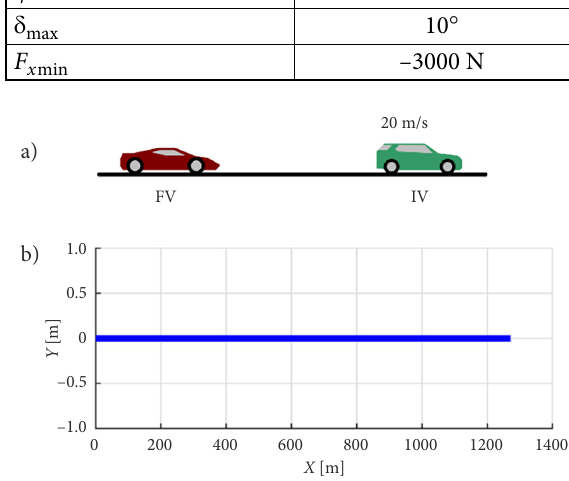
Figure 6. Path and initial condition